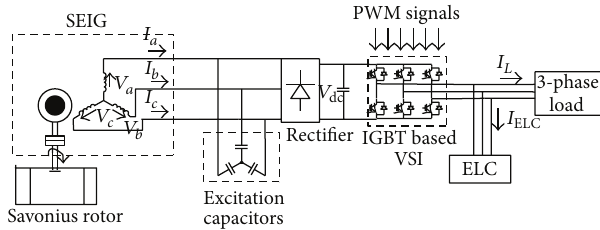
Figure 1: Schematic diagram of power generating scheme.